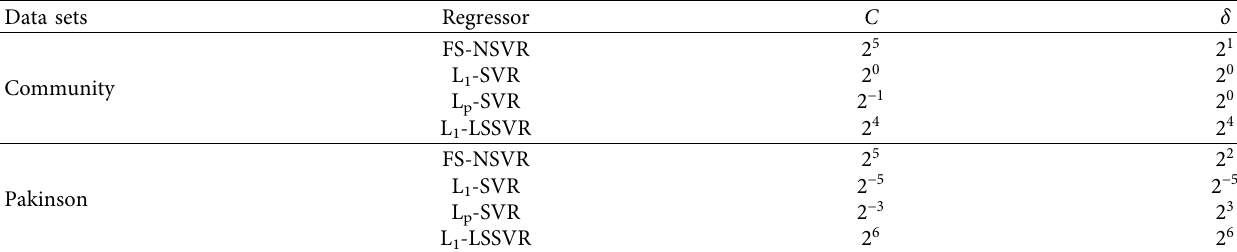
Table 5: Comparison results of FS-NSVR, L Data